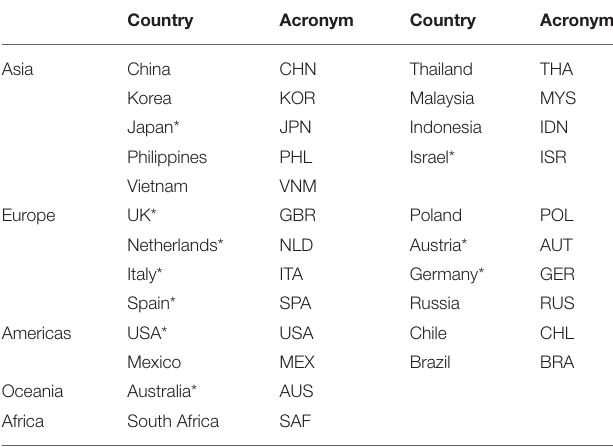
TABLE 1 | Countries and country